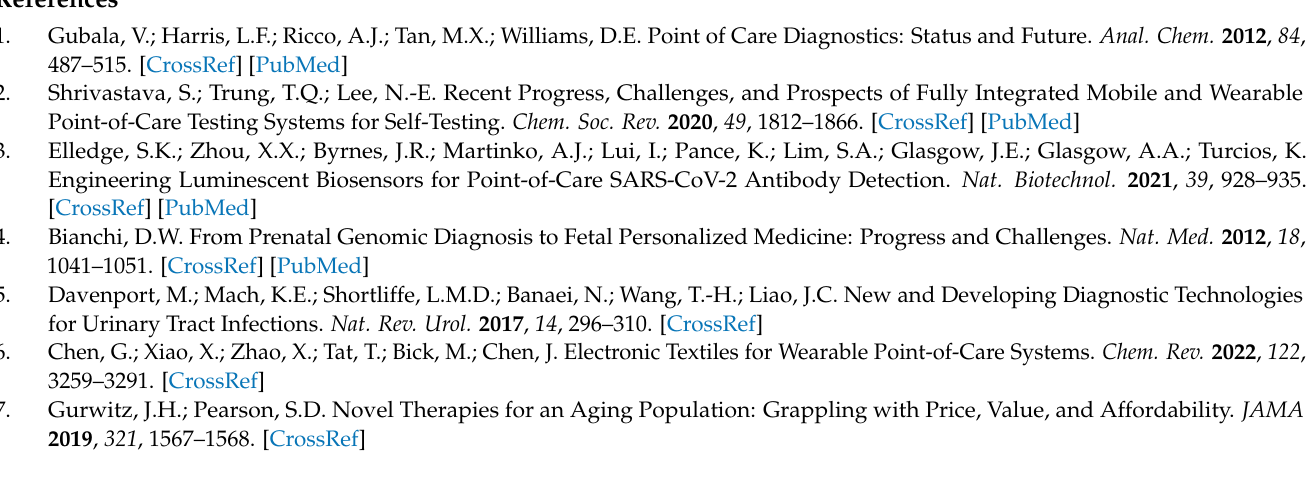
Table S2: Loss/accuracy versus epoch for train and validation sets; Table S3: Comparison of different methods in terms of accuracy; Table S4: Classifier evaluations index; Table S5: Cost of each component for the point-of-care system in detail.; Figure S1: Pin configuration and peripheral circuit diagram of ADS1292; Figure S2: Photo of fabricated